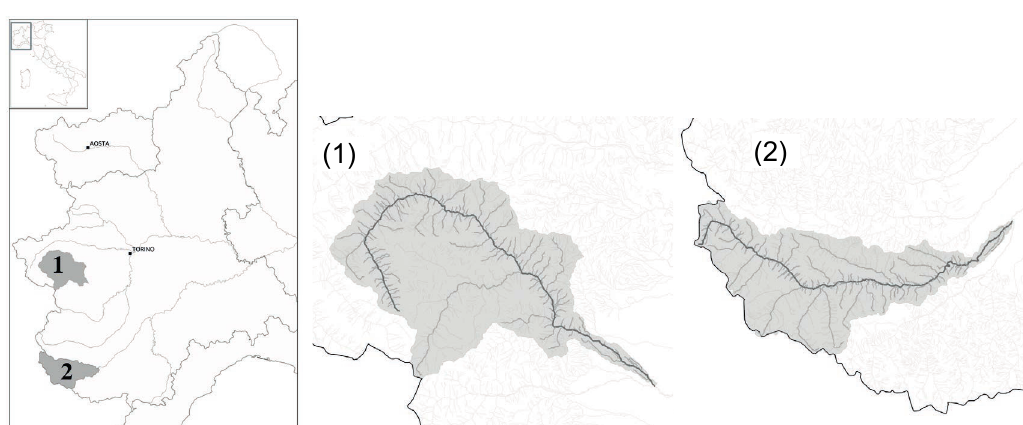
Fig. 2 Piemonte Region, in NW of Italy and case study basins. Chisone (1) and Stura di Demonte